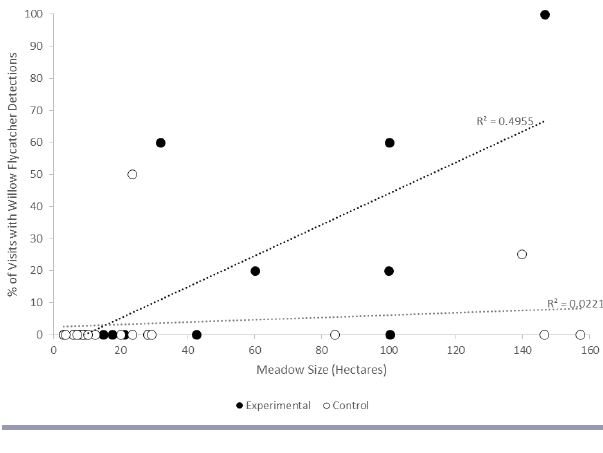
Fig. 2 . The relationship between meadow size and the percentage of survey visits where Willow Flycatchers ( Empidonax traillii ) were positively detected at any time during the breeding season, including one site where a nonterritorial Willow Flycatcher was detected once, prior to the 15 June cutoff we established for documenting colonization. Experimental sites where conspecific broadcasts took place are represented by black circles and control sites without broadcasts are represented by white circles. Regression lines depict the relationship between meadow size and detection for experimental sites (in black) and control sites (in gray).